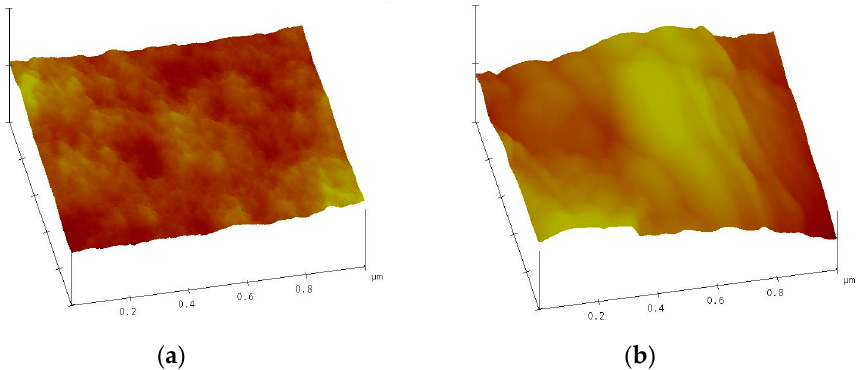
Figure 5. Atomic force microscopy (AFM) images of ( a ) the QD–AF membrane and ( b ) the horseradish peroxidase (HRP) QD–AF membrane. Sensors 2019 , 19 , x FOR PEER REVIEW